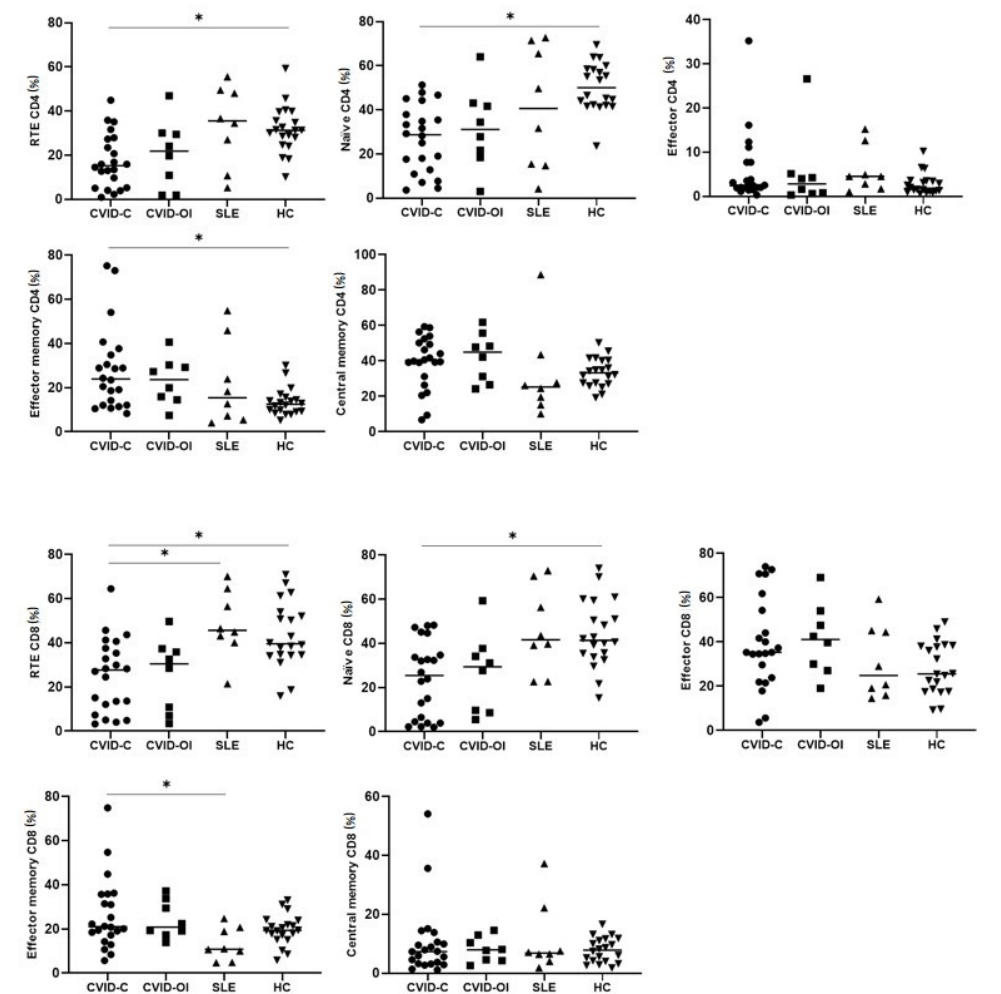
Figure 5. Differences in the proportions of T lymphocyte maturation between CVID with complicated phenotype (CVID-C) group, CVID phenotype limited to only infections (CVID-OI group), patients with SLE, and healthy controls (HCs). Data expressed as median (Q1–Q3), * p < 0.05.